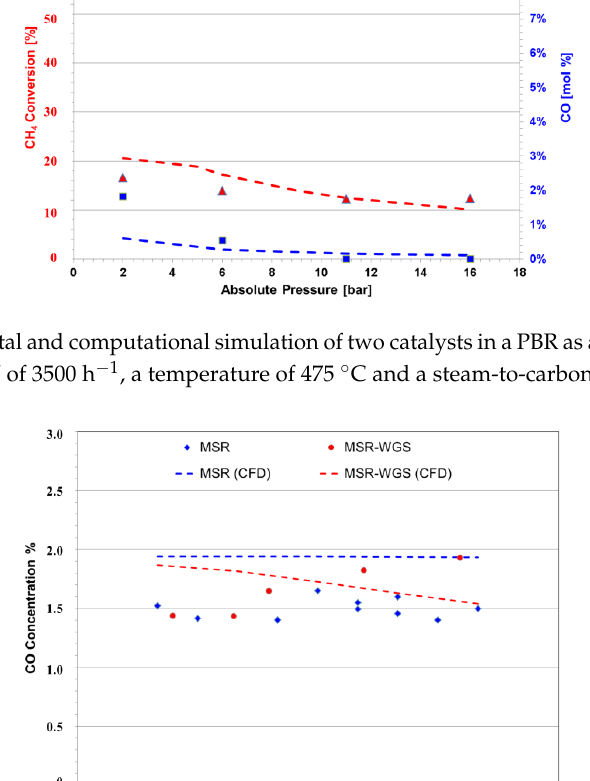
Figure 6. Experimental and computational simulation of two catalysts in a PBR as a function of